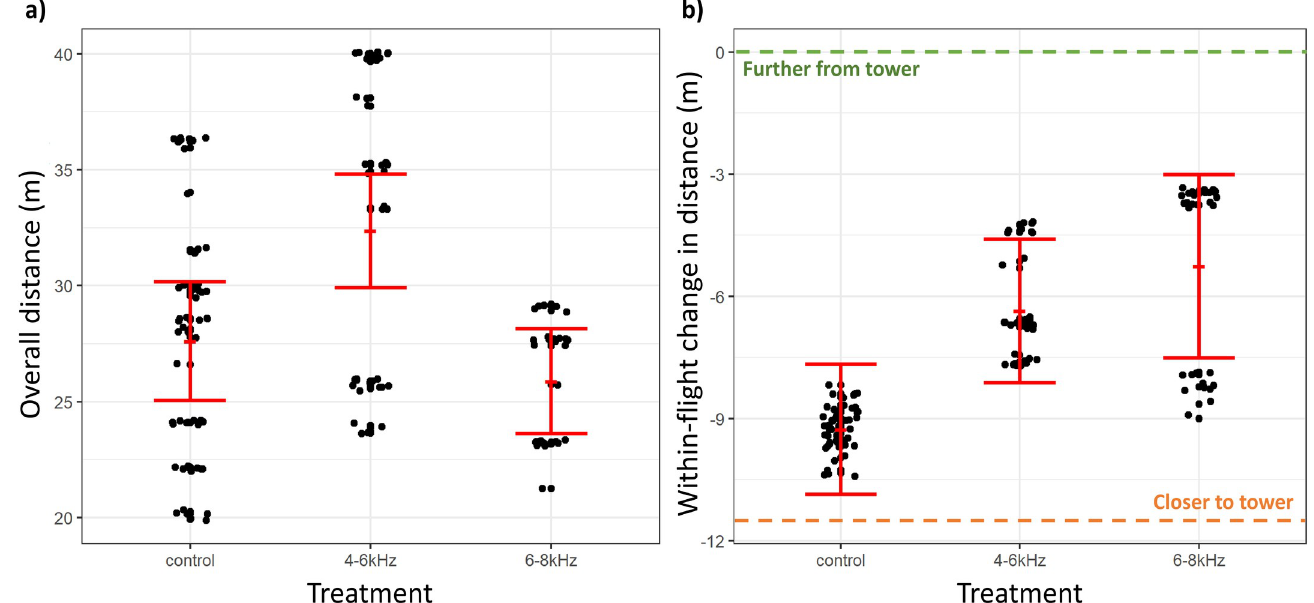
Fig 3. Distance from towers by treatment condition. Panel a) shows the overall distance from towers by treatment condition. Panel b) shows the within-flight change in distance from towers by treatment condition. Solid red dots and error bars represent model-averaged mean of outcome variable ± standard error of the mean. In panel b), the green dotted line indicates a level of change in distance where flights remain further away from towers and the orange dotted line indicates a level of change in distance where flights draw closer to